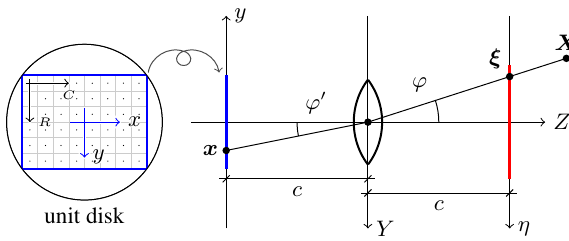
Figure 1. Camera model showing (1) the sensor with integer R - C -pixel grid and centered x - y -coordinate system, (2) the lens and world X - Y - Z -coordinate system, (3) the scene plane (red) and sensor plane (blue, rotated upside down) with their ξ - η - and x - y -coordinate systems, resp., and (4) a 3D scene point X , it’s projection ξ onto the scene plane and x onto the sensor plane with distortion ϕ to ϕ (cid:48) . Notes: The world, sensor, and scene coordinate systems are scaled such that the sensor has a diagonal of 2 units length, i.e. the whole sensor fits exactly in the unit disk. x is located on the plane containing X and the world’s Z -axis. The sensor, as shown on the left hand side, is illuminated from the backside. The world’s X -axis and scene plane’s ξ -axis point towards the reader and the sensor plane’s x -axis points opposite; these axes are omitted in the image. The distance c between the lens and the sensor plane is the adjusted focal length (relative to the sensor size) and determines the field of view of the camera, the distance c between the lens and the scene plane is chosen for